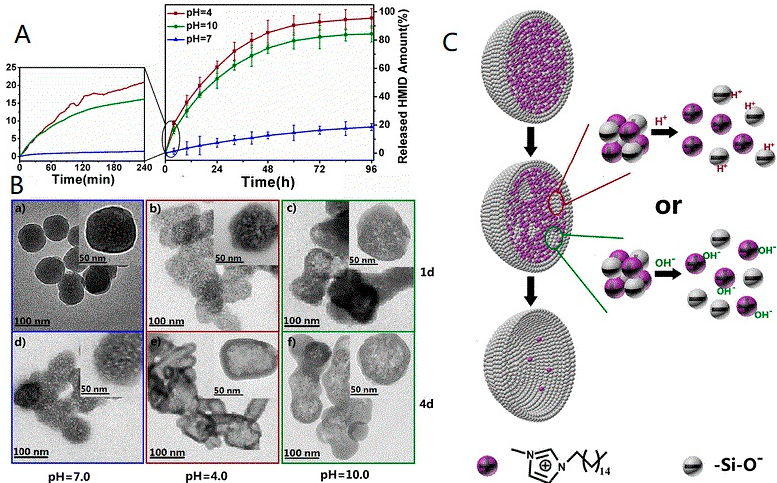
Figure 7. ( A ) Release profiles of HMID from SiO 2 -IMI at different pH values; ( B ) TEM images of the SiO 2 -IMI taken after being immersed in solution with different pH values (( a , d ) pH = 7.0, ( b , e ) pH = 4.0, and ( c , f ) pH = 10.0) for ( a – c ) 1 day and ( d – f ) 4 days; ( C ) The acid/alkali stimuli-accelerated release mode of SiO 2 -IMI. Reproduced from [67] with permission; Copyright Springer